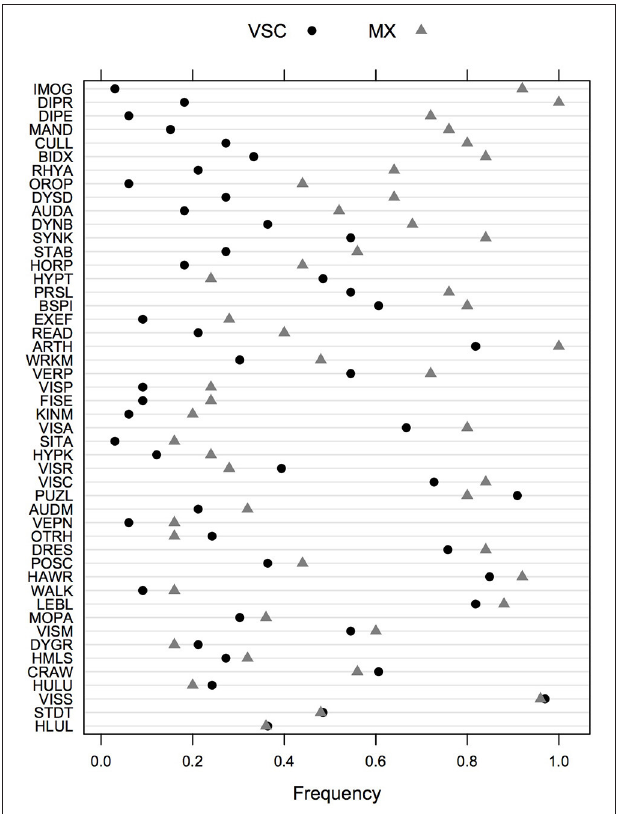
FIGURE 1 | Frequency of impairments in VSC and MX patients for the whole test battery. Items are ordered in decreasing order of absolute difference between the two groups. VSC, Visuo-spatial/visuo-constructional subtype DCD; MX, Mixed subtype DCD.